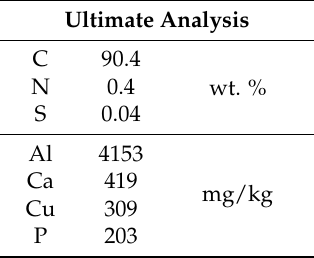
Figure 2. ( a ) XRD pattern for the snack packaging plastics waste and ( b ) FTIR spectrum for the snack packaging plastics waste. Table 2. Elemental composition of snack packaging plastic waste. Table 2. Elemental composition of snack packaging plastic